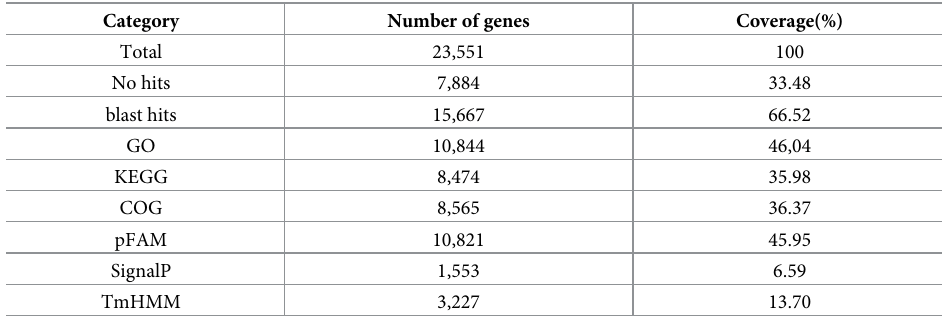
Table 2. Annotation of genes of the P. b. seulensis .